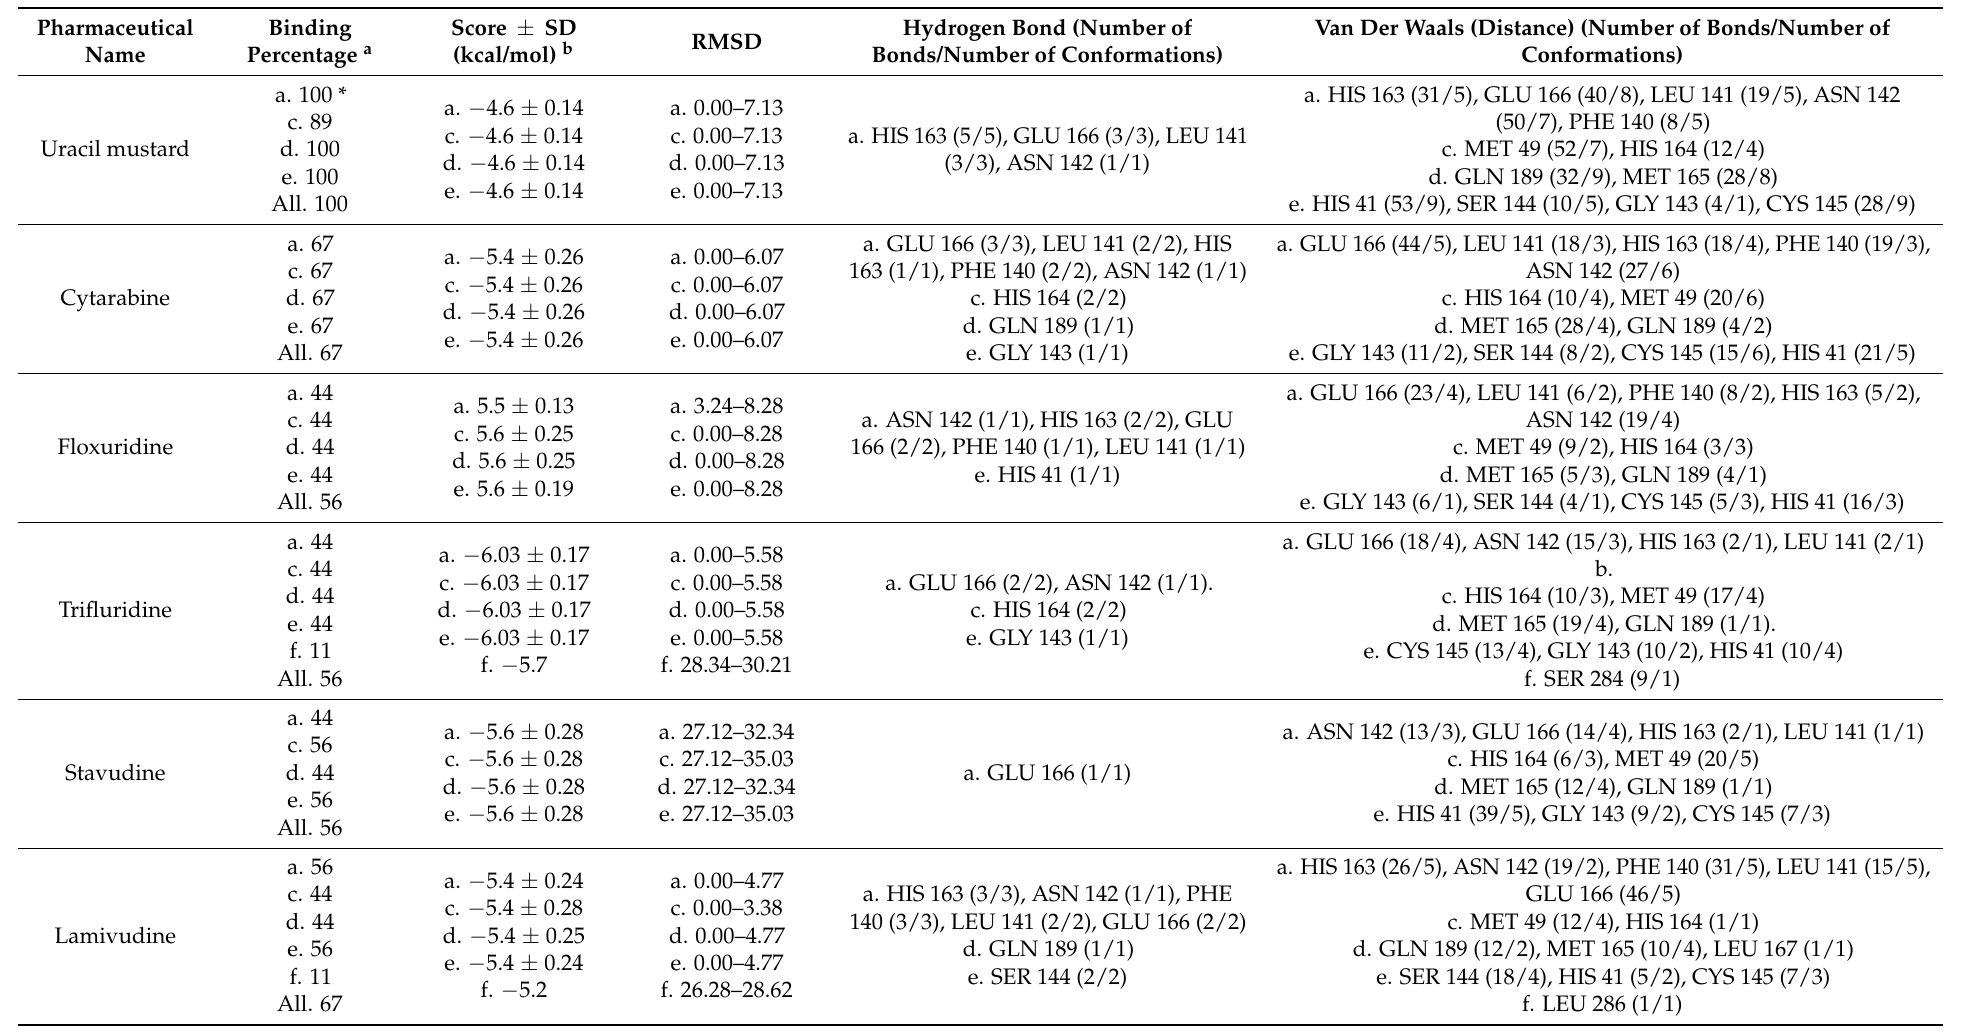
Table 2. The binding affinities of the potential pyrimidonic pharmaceuticals with 3-chymotrypsin-like protease (3CL pro